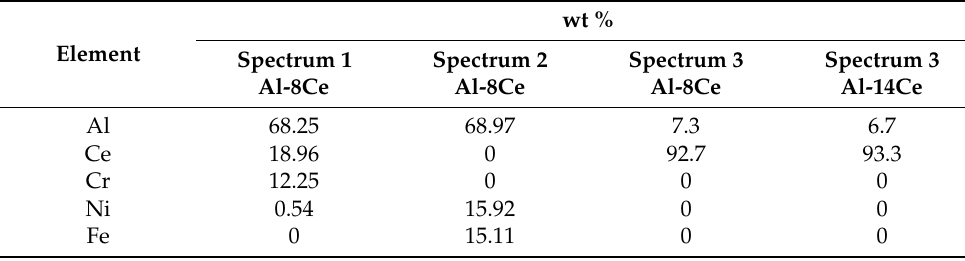
Table 1. EDS spectrum elemental composition in wt